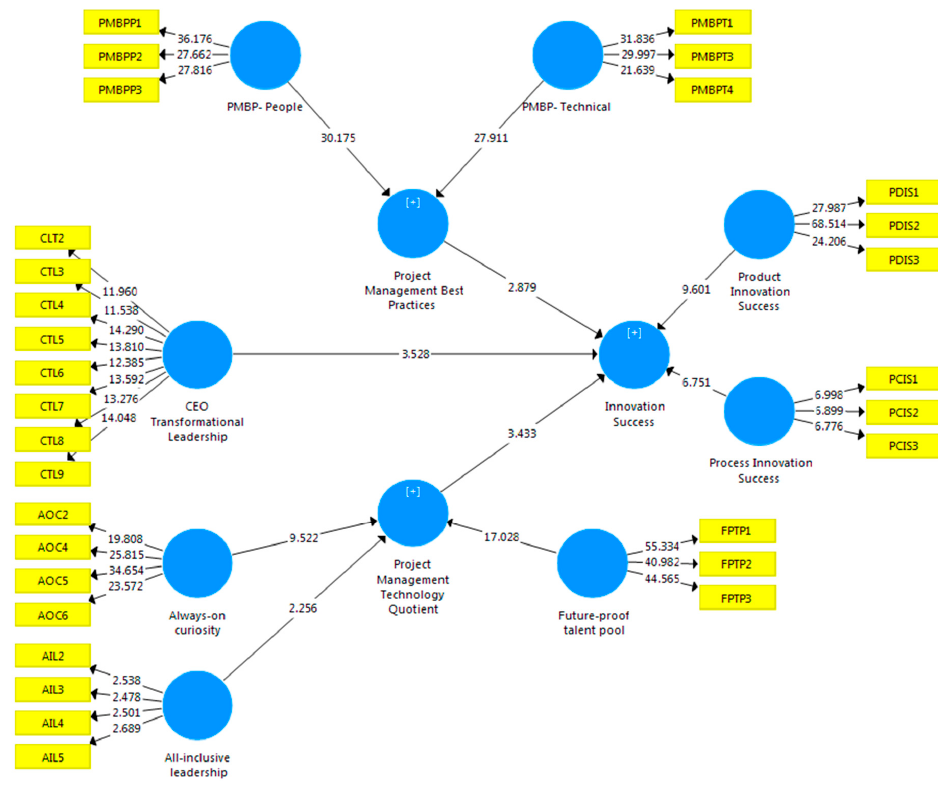
Figure 2. Structural model of innovation success. Table 6. Summary of the structural model.